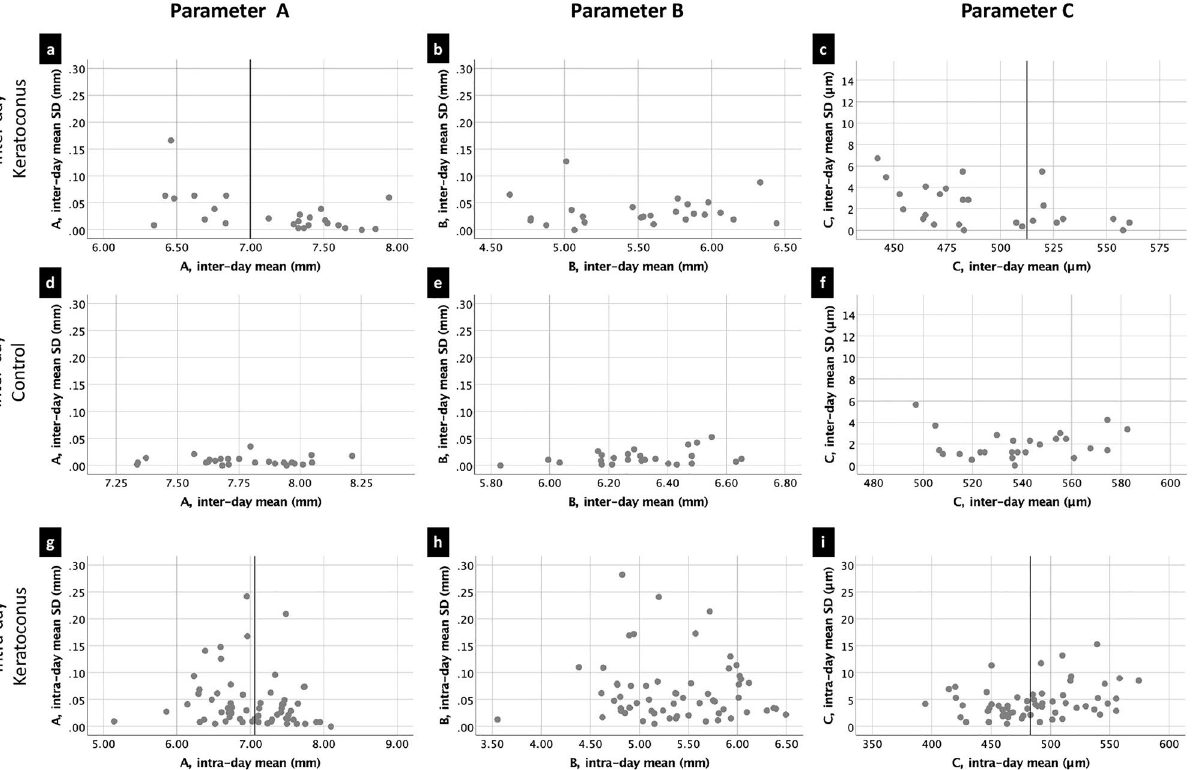
Figure 1. Mean values of inter-day and intra-day measurements of the parameters A, B and C, plotted against the standard deviation. ( a ) Inter-day measurements of parameter A in subjects with keratoconus, ( d ) inter-day measurements of A in control patients, ( b ) inter-day measurements of B in subjects with keratoconus, ( e ) inter- day measurements of B in the control group, ( c ) inter-day measurements of C in subjects with keratoconus and ( f ) inter-day measurements of C in the control group. Lower values of parameters A and B indicate more severe keratoconus, while lower values of C indicate less severe disease. The vertical lines indicate the median.